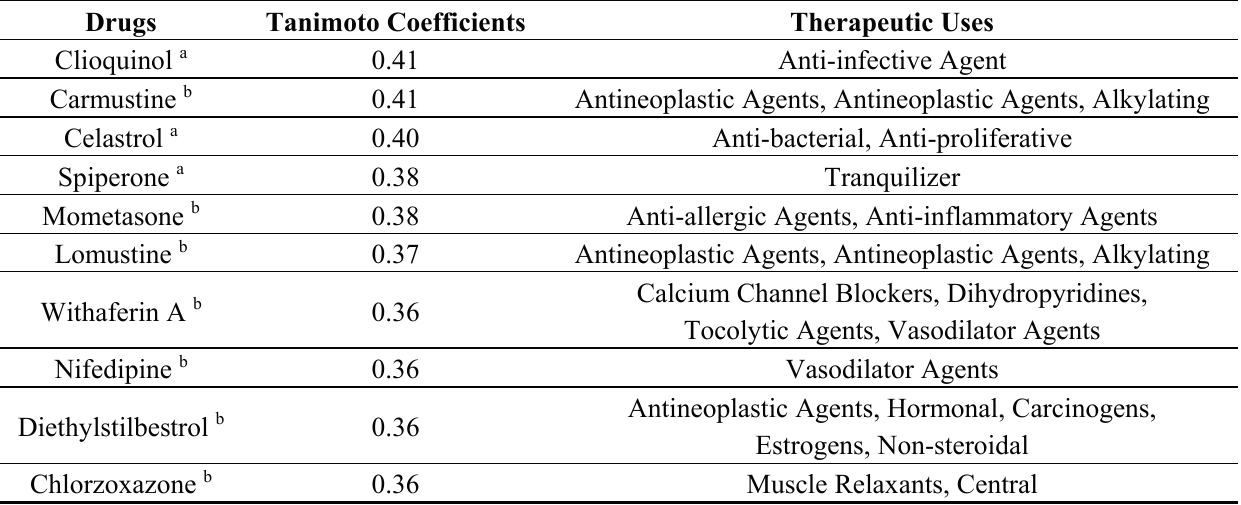
Table 2. Predicted similar drugs to